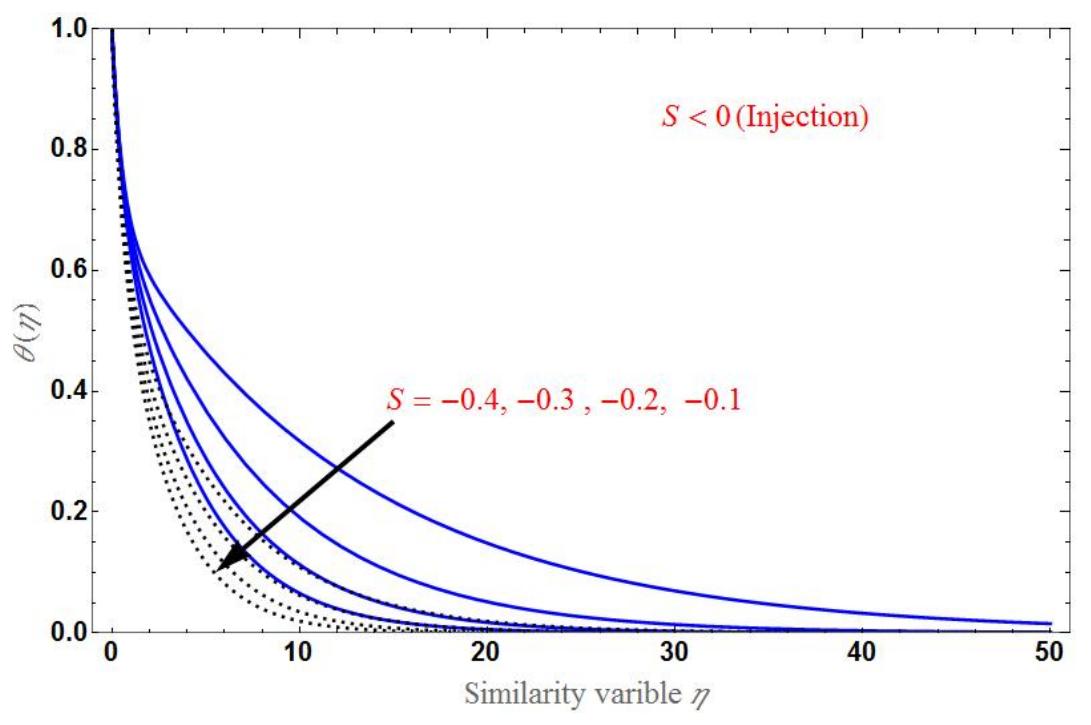
( ) θ η as a function of η for several values of S . The other Figure 10. The temperature profile Figure 10. The temperature profile θ ( η ) as a function of η for several values of S . The other fixed parameters are: M = Λ = Da − 1 = N R = 1, φ 1 = 0.1, φ 2 = fixed parameters are: